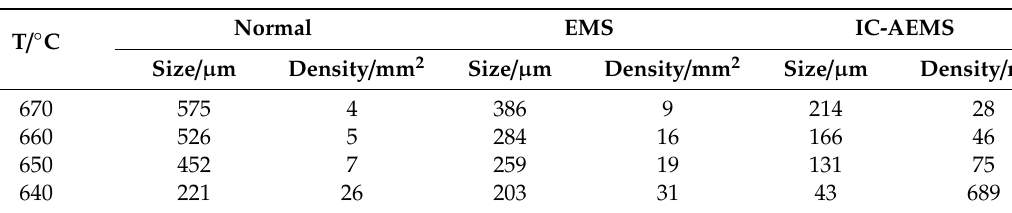
Table 2. Average grain size and grain density measured from Al-Zn-Mg-Cu-Zr alloy solidified under di ff erent conditions and pouring temperatures.